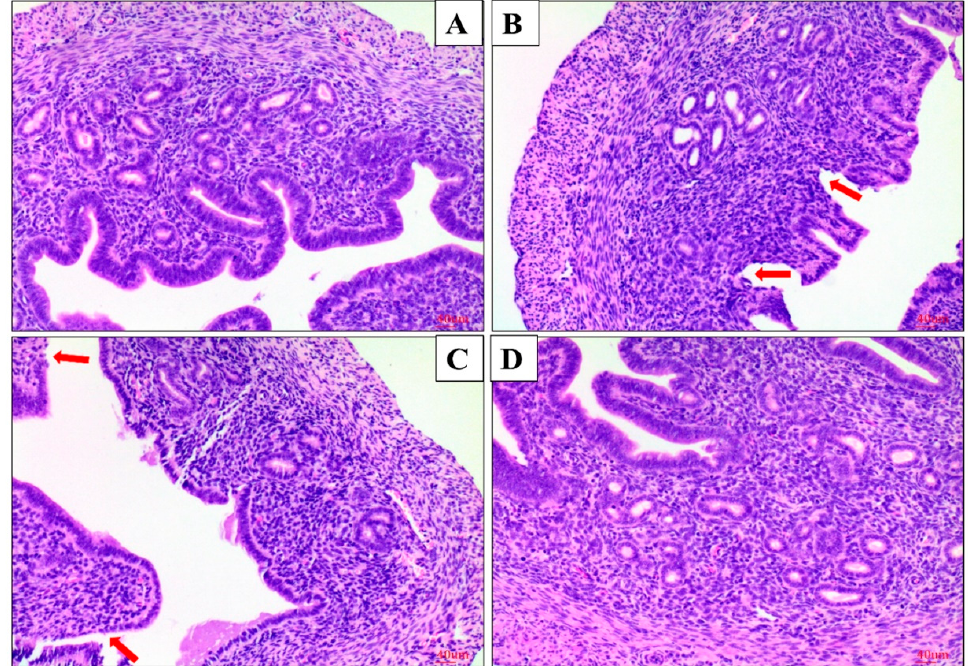
Figure 3. Effects of Astragaloside IV on LPS-induced histopathological changes of uteri (HE, × 200). Mice uteri from each group ( n = 15) were processed for histological evaluation at 24 h after LPS infusion. The shedding of epithelial cells and the destroyed integrity of the endometrium in the endometritis group were observed. Red arrows represent the imperfection of the endometrium and the shedding of epithelial cells. ( a ): LPS − /AS IV − group. ( b ): LPS + /AS IV − group. ( c ): LPS + /AS IV + group. ( d ): LPS − /AS IV + group.